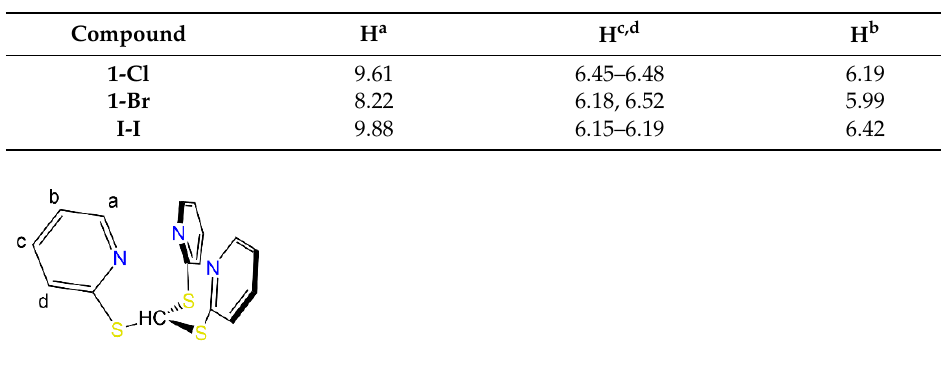
Figure 1. Atom labelling of HTptm.